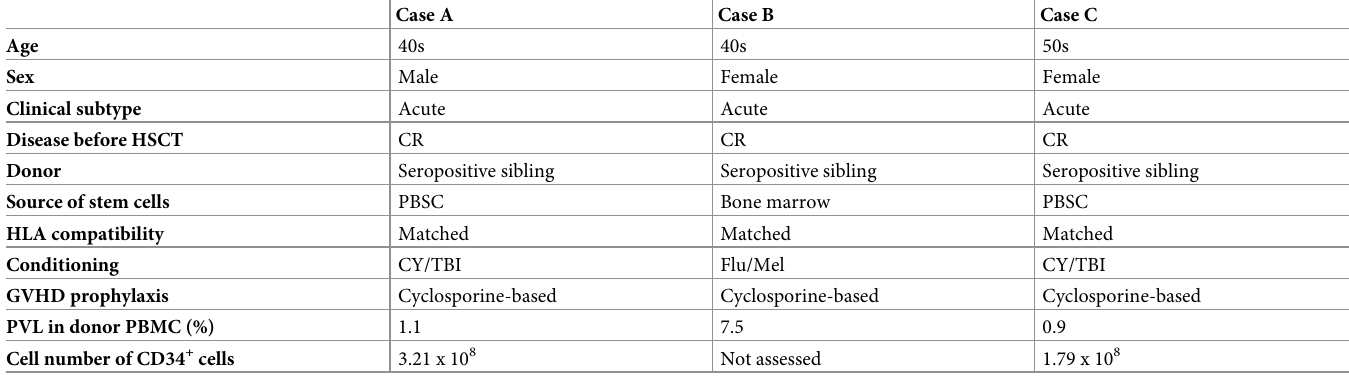
Table 2. Clinical data of allogeneic hematopoietic stem cell transplantation from seropositive